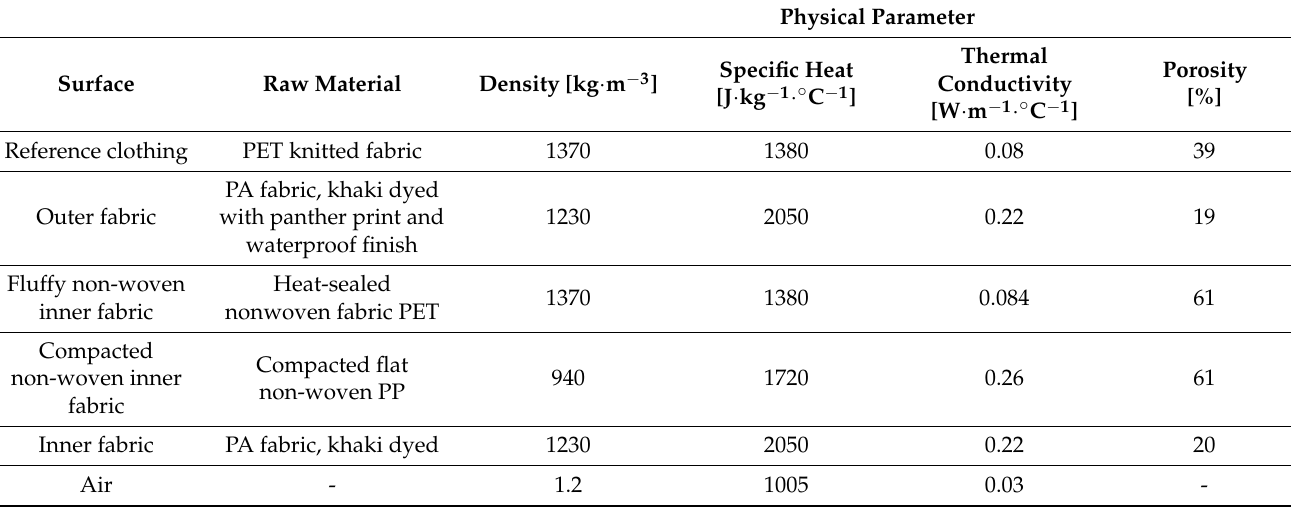
Table 2. Physical features of the raw materials applied in simulations.